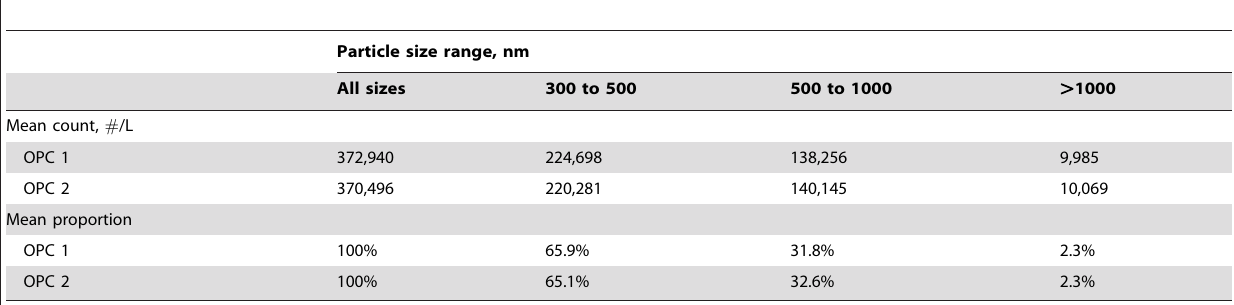
Table 2. Mean count and proportion of particle size ranges of 300 to 500 nm and 500 to 1000 nm according to OPC measurements.